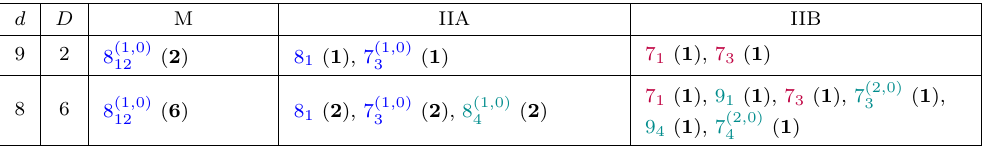
Table 14 . Branes in the 7-brane multiplet.